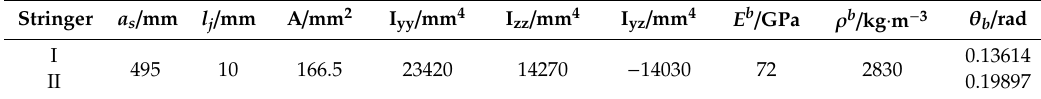
Table 1. Geometric and material property parameters of stringers.